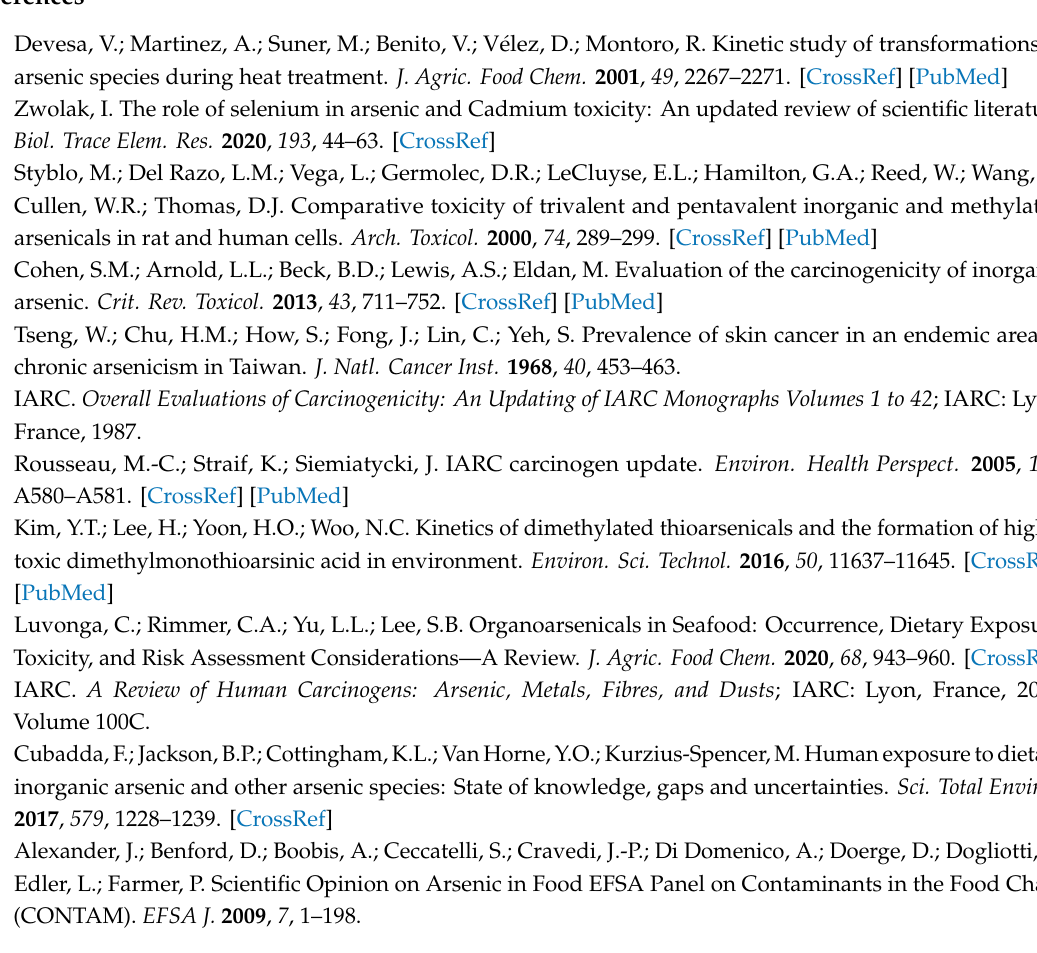
Figure S1: Map of sampling cities on the south coast of Korea, Table S1: Target compounds, structure, and molecular weight, Table S2: Instrumental operating conditions of HPLC and ICP-MS for arsenic